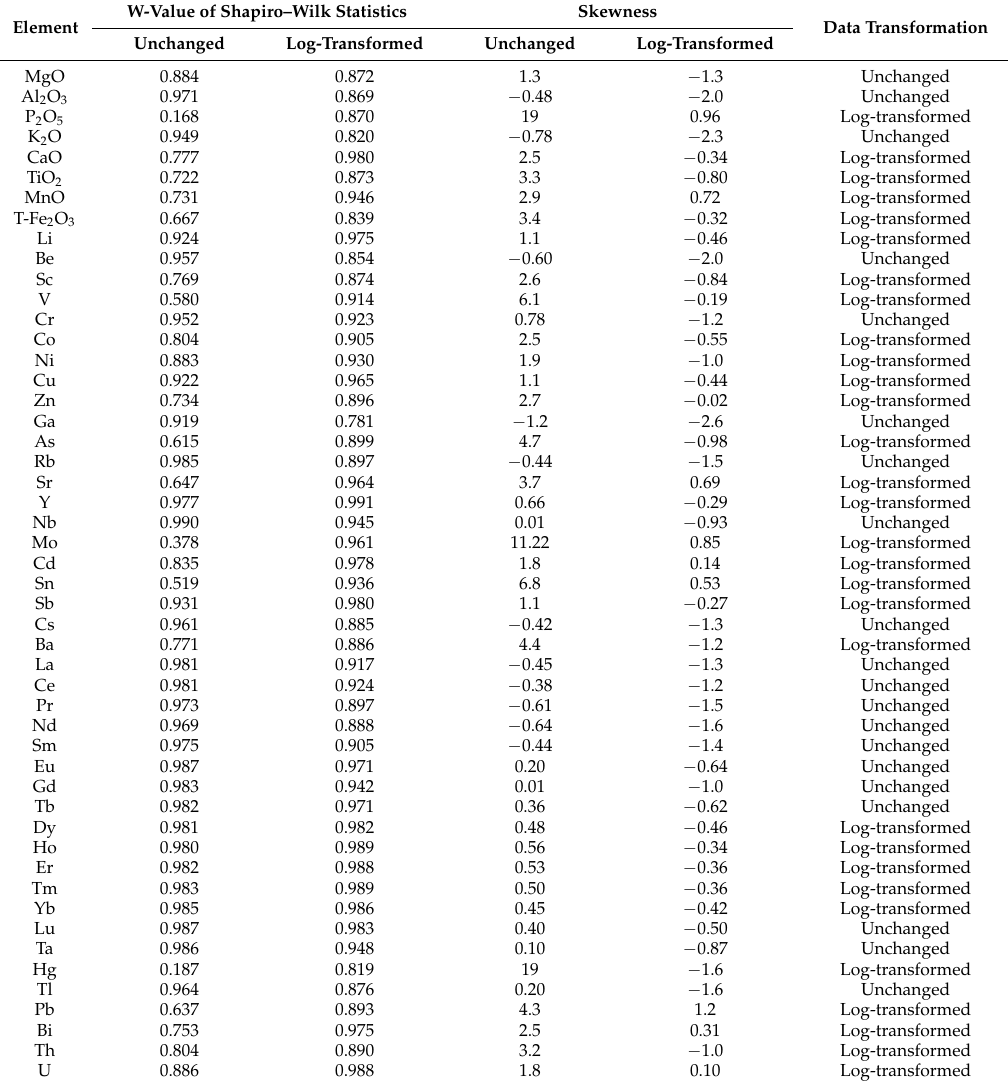
Table C1. For example, K 2 O data are unchanged for ANOVA because the Shapiro–Wilk statistics and the skewness of unaltered K 2 O data are closer to 1.0 and zero, respectively, than those of log-transformed K 2 O data (Table C1). On the basis of this analysis, data for 24 elements within the marine sediments were log-transformed, with the remaining data left unaltered for ANOVA (Table C1). Table C1. The Shapiro–Wilk test applied to the unchanged and log-transformed data and their